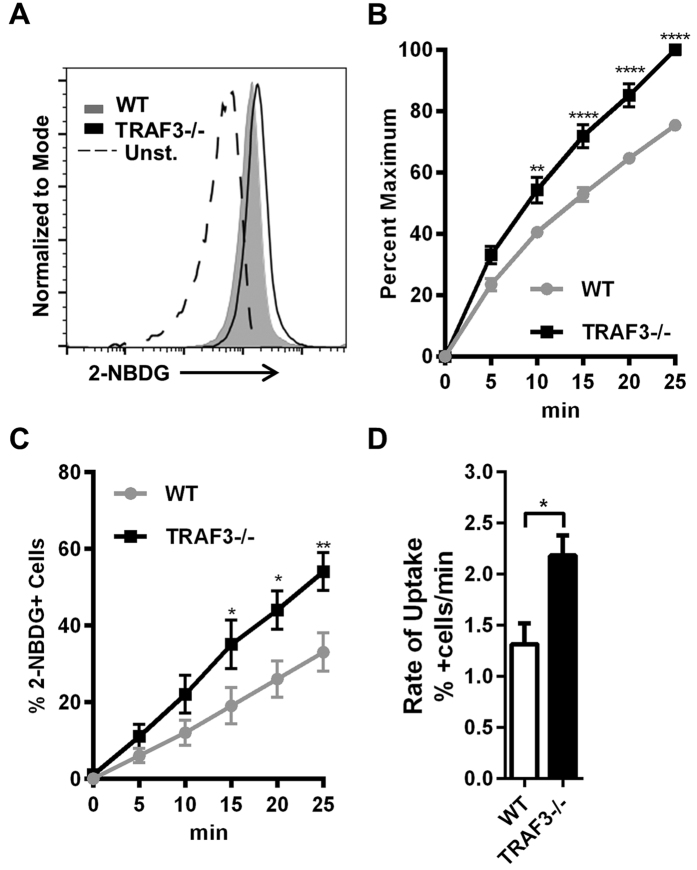
TRAF3 mediated regulation of glucose uptake in B cells.(A–D) B cells were isolated from littermate WT and B-Traf3−/− mice. (A–C) Cells were incubated in the presence of 2-NBDG. Representative histogram of 2-NBDG uptake at 25 minutes, including an unstained sample, is shown (A). Median fluorescence intensities normalized as % maximum (B) and % of 2-NBDG positive cells (C) ±SEM at indicated time points are shown. Two-way ANOVA was used to analyze results for statistical significance and adjusted p value was calculated using the Bonferroni method (n = 3 independent experiments, *p < 0.05, **p < 0.01, ****p < 0.0001). (D) Rate at which cells take up 2-NBDG is shown, calculated from linear regression ± SEM from three independent experiments. Student’s t-test was used for statistical significance (*p < 0.05).